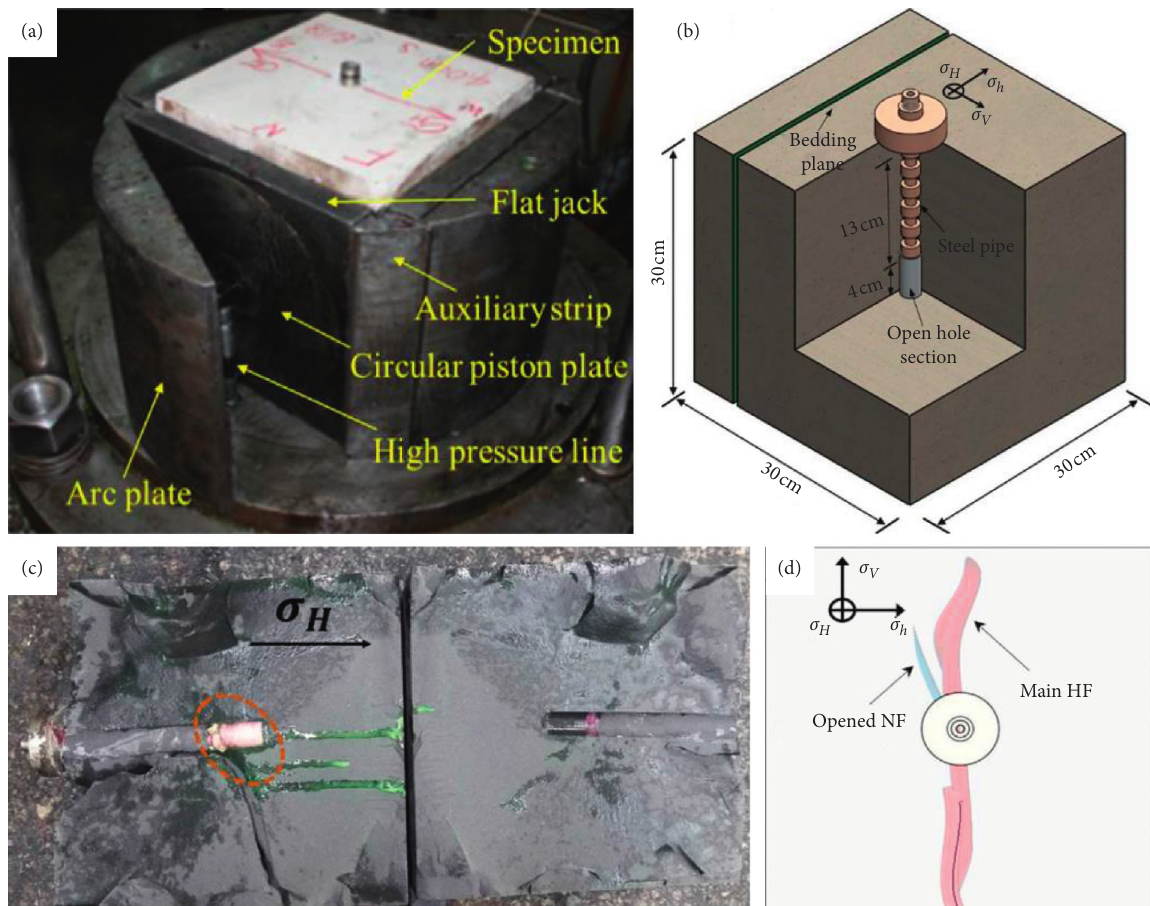
Figure 1: A laboratory-scale hydraulic fracturing experiment [10]. (a) True triaxial test stand. (b) Schematic of sample and wellbore. (c) Sample after hydraulic fracturing. (d) Schematic of main hydraulic fracture (HF) and opened natural fracture